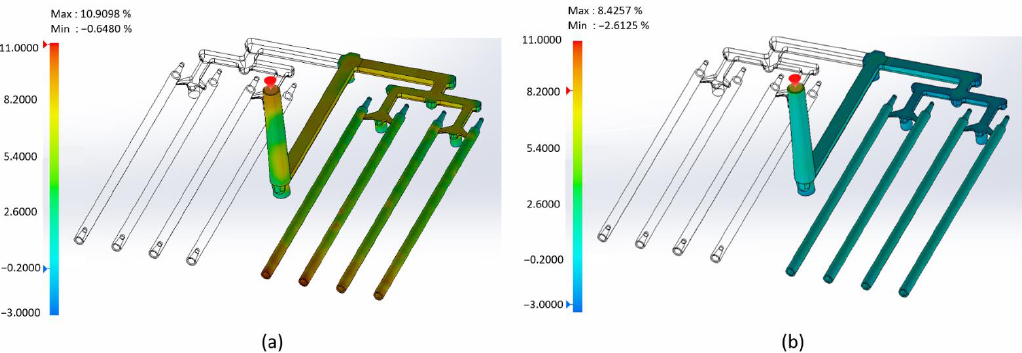
Figure 8. ( a ) Temperature at the end of packing—clipping section through the stick; ( b ) external joint areas; and ( c ) internal joint areas.